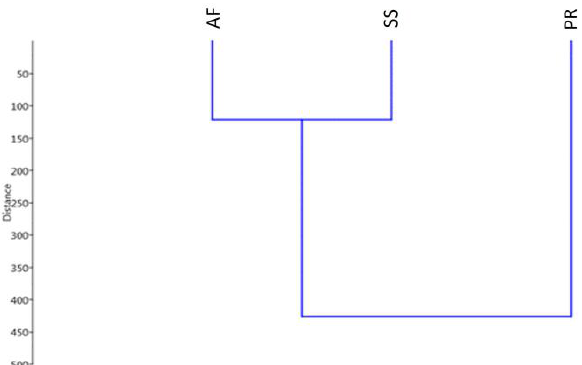
Figure 1. Cluster analysis of local populations in the study base on morphological and production data. Local population code: PR = Prizzi; AF = Alcara Li Fusi; SS = S. Stefano Quisquina. Table 4. Average values regarding morphological and production characteristics of the populations in each